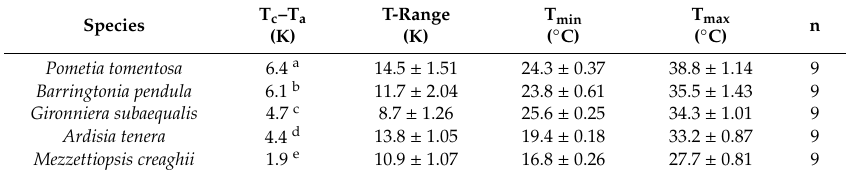
Figure 2. The false color thermal image of part of the canopy of five tree species taken at 14:00 on 4 February 2018, shows the canopy surface temperature of five di ff erent tree species. The squares show some selected frames that have been used (Table 1 and Figure 5). Table 1. The average canopy temperature repeat number n, canopy temperature di ff erence (CTD), temperature range, minimum and maximum values of the five rainforest tree species selected in the study (letter a~e represents the di ff erence from high to low at the significant level of 0.05 ( p <